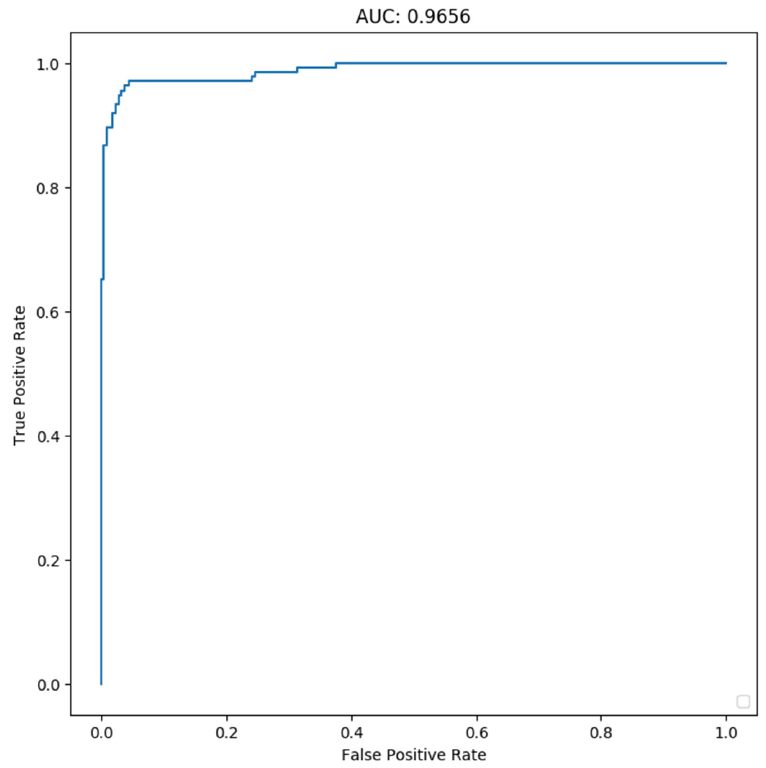
Figure 6. ROC curve of the brain tumor classification model.